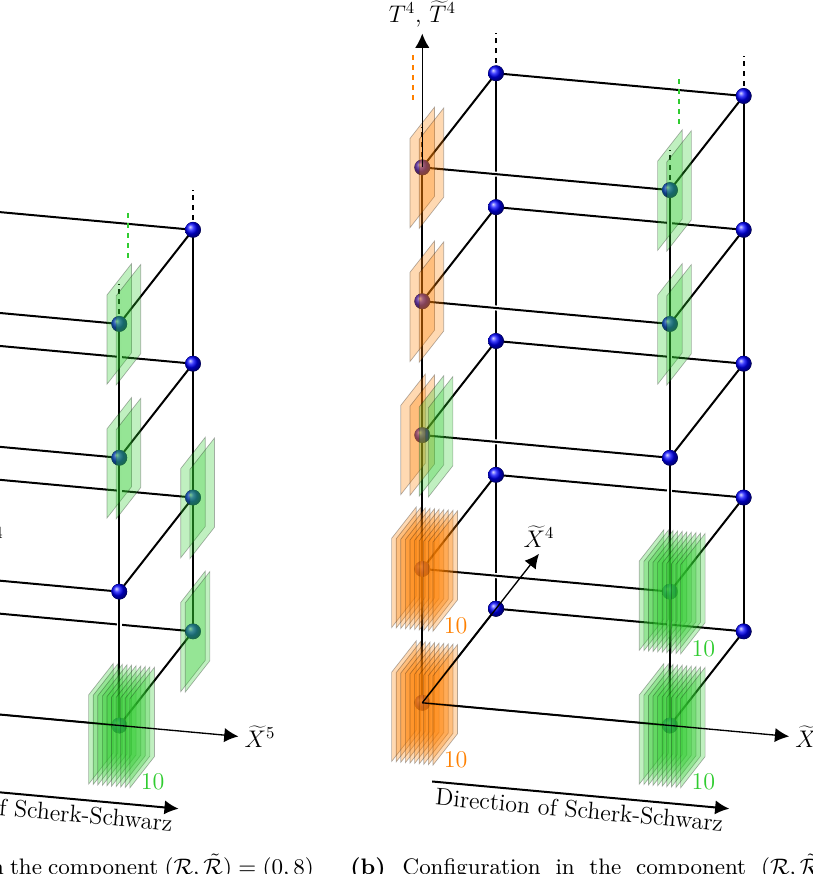
Figure 5. D3-brane configurations without tachyons at one loop in the NN, DD and ND+DN open-string sectors, as well as in the untwisted closed string